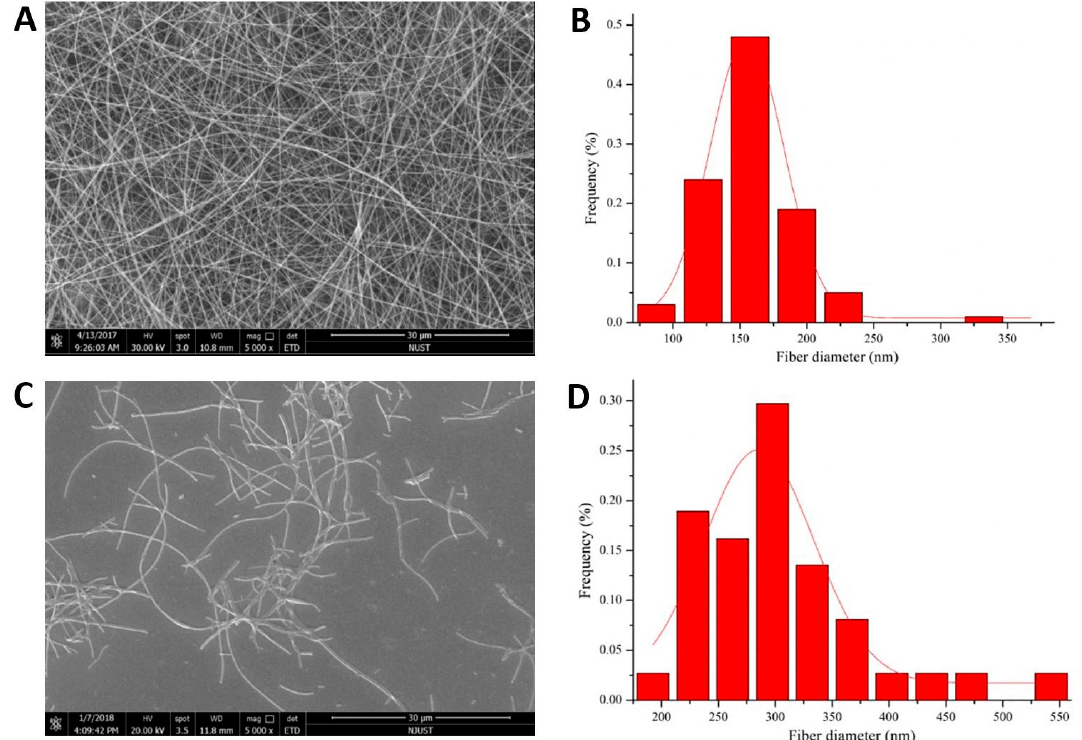
Figure 1. Structure of the electrospinning nanofibers and short nanofibers. ( A ) SEM image of the electrospun nanofibers. ( B ) Diameter distribution of the electrospun nanofibers. ( C ) SEM image of the homogenized short nanofibers. ( D ) Diameter distribution of the homogenized short nanofibers.